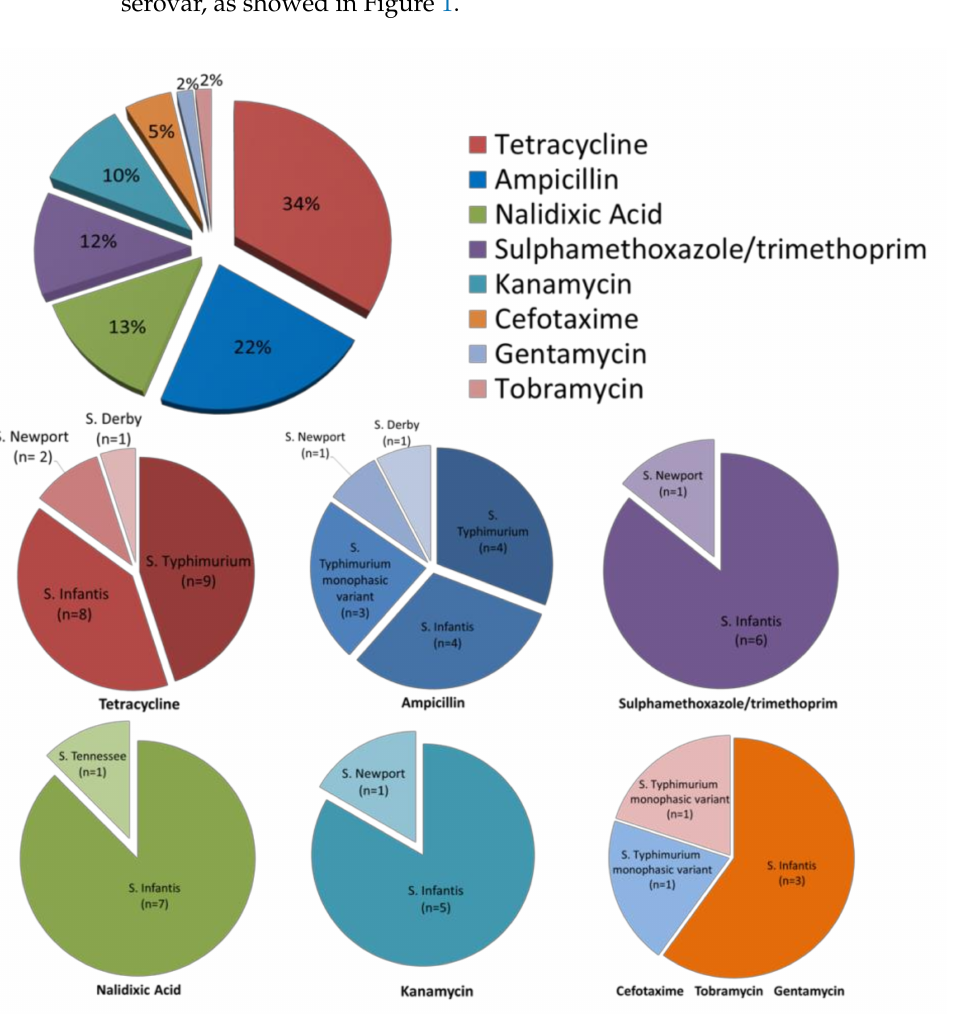
Figure 1. Phenotypic resistance profile of 60 Salmonella